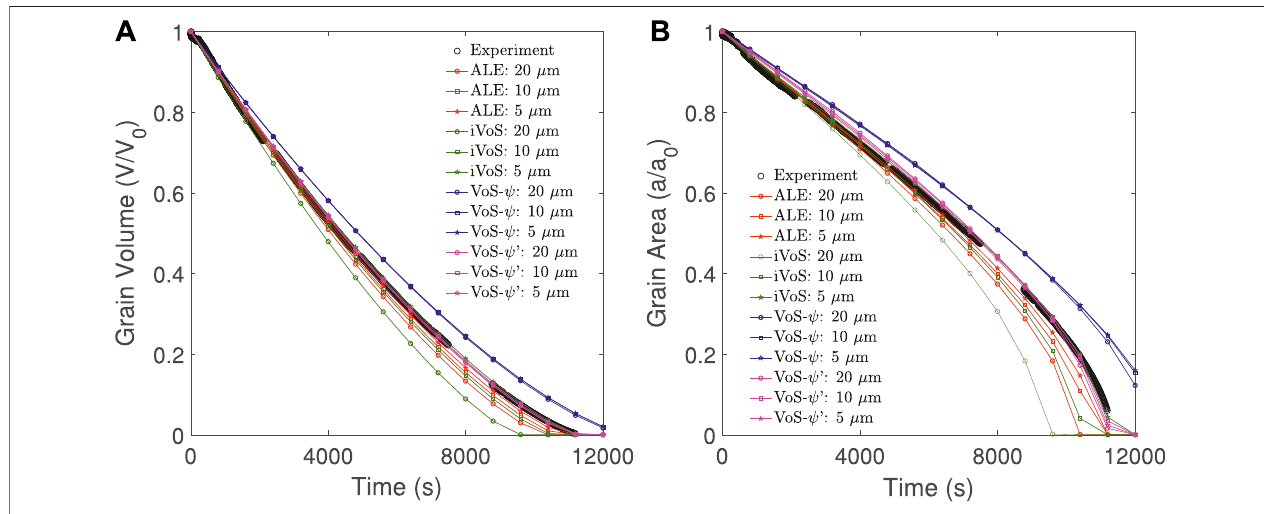
FIGURE 2 | Evolution of (A) the grain volume and (B) the grain surface area obtained experimentally (black) and with simulation using the ALE (red), VoS- ψ (blue),, VoS- ψ ’ (purple) and iVoS (green) methods at various mesh resolutions during dissolution of a calcite post by acid injection.